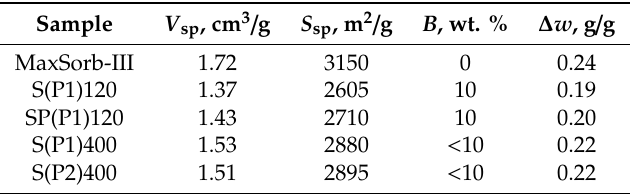
Table 4. Specific pore volume V sp and surface area S sp , binder content B , and methanol exchange ∆ w (cycle 2) during the dynamic tests for the compacted MaxSorb III